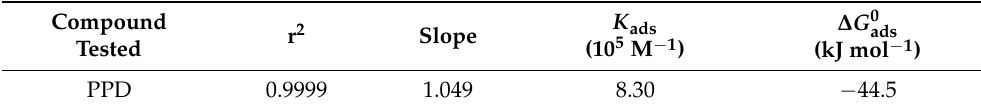
) for the electrochemical system studied. ads